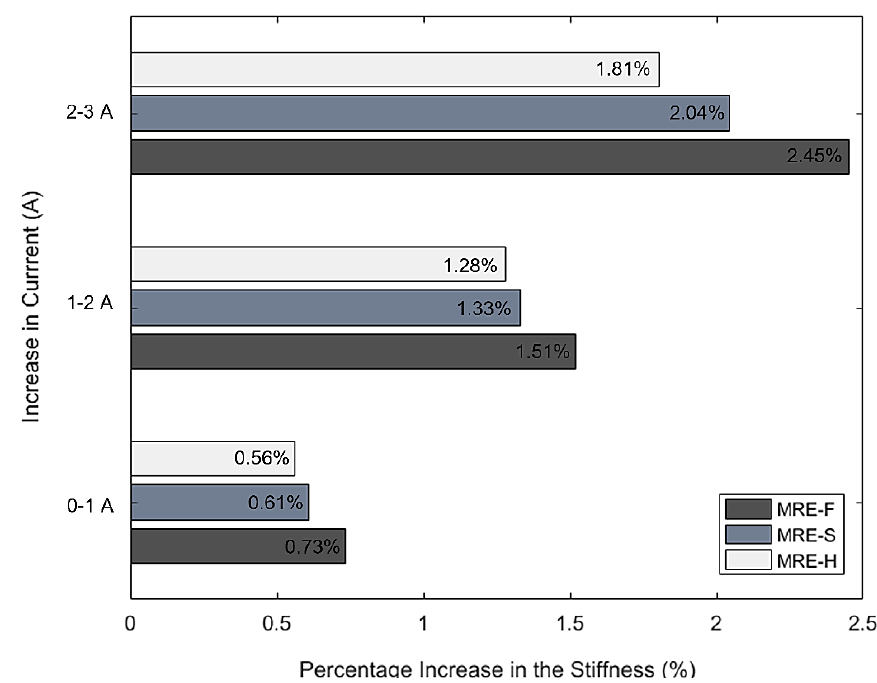
Figure 11. Percentage increase in stiffness for MRE-F, MRE-S, and MRE-H.